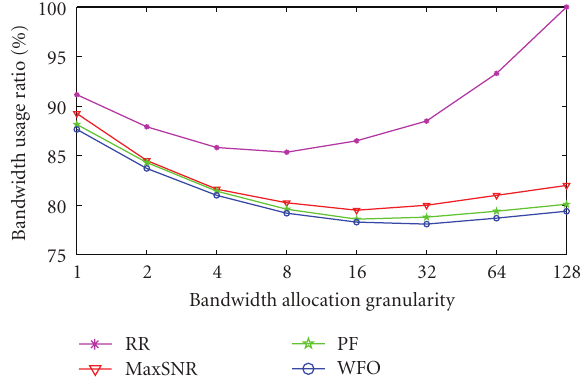
Figure 6: System capacity